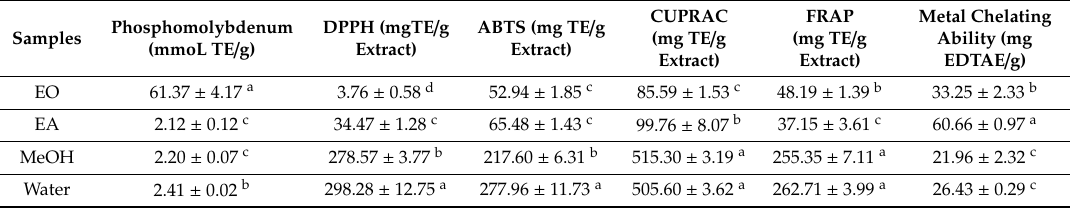
Table 3. Antioxidant activities of the tested